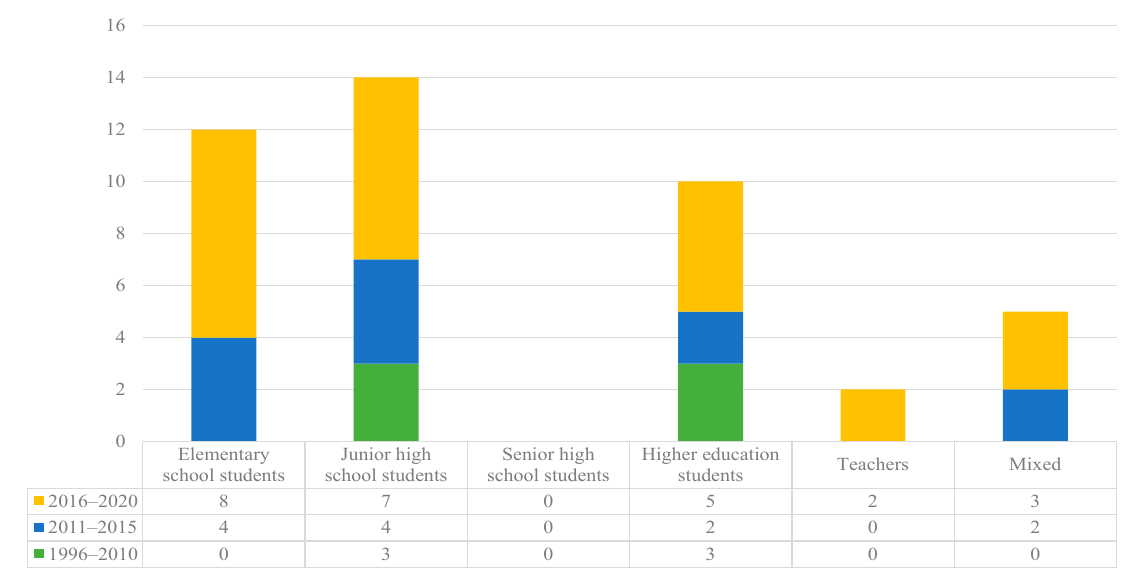
Figure 9. Research sample groups of AIME research in each period.